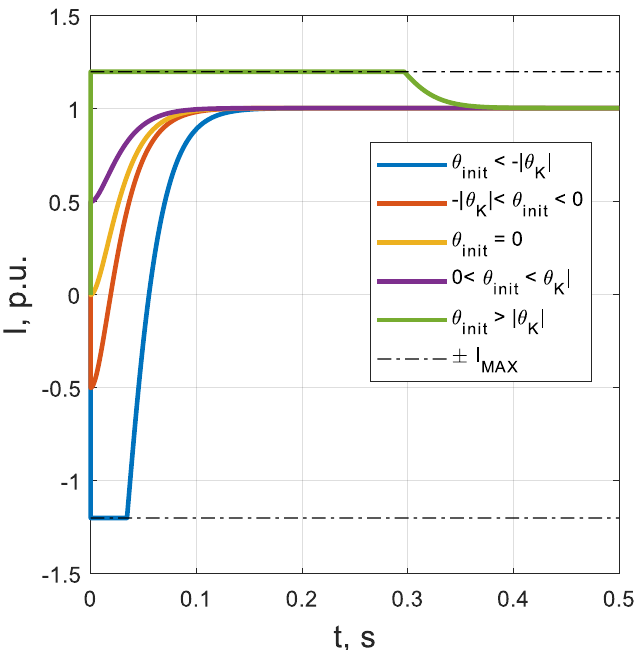
Figure 10. Current amplitude curves for different initial phases of P-f loop at post-fault period.